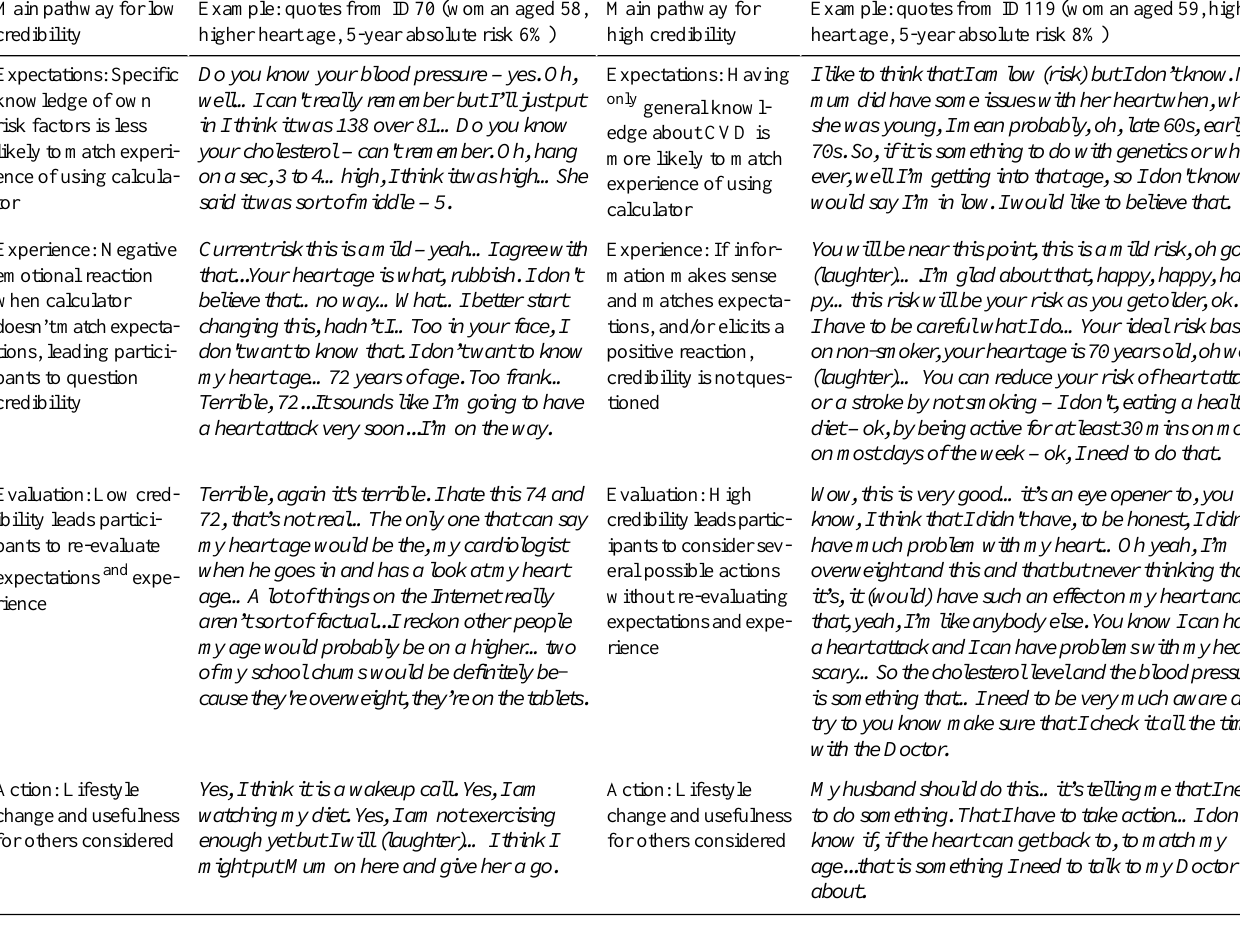
Table 3. Examples of main pathways for low vs high